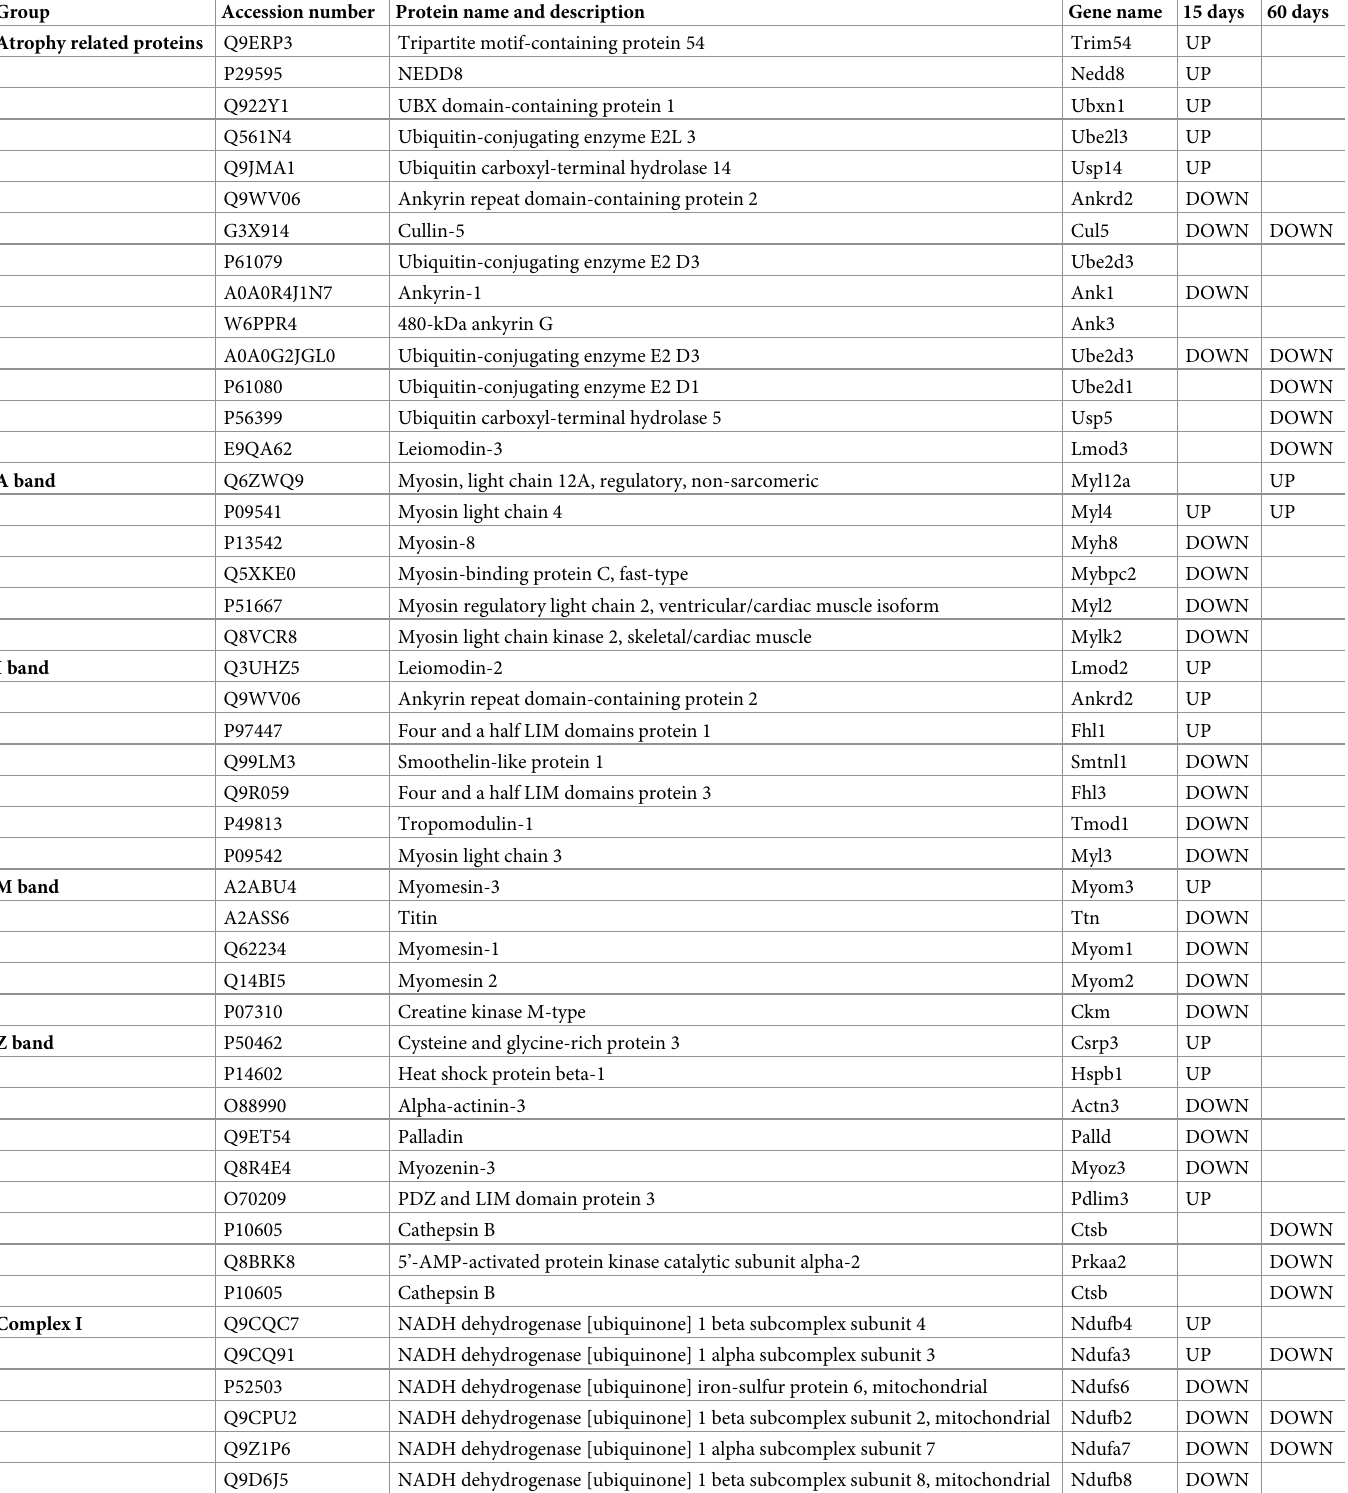
Table 2. Differential regulation of proteins related to all mitochondrial complexes, sarcomeres, atrophy and Ubiquitine proteasome pathway.